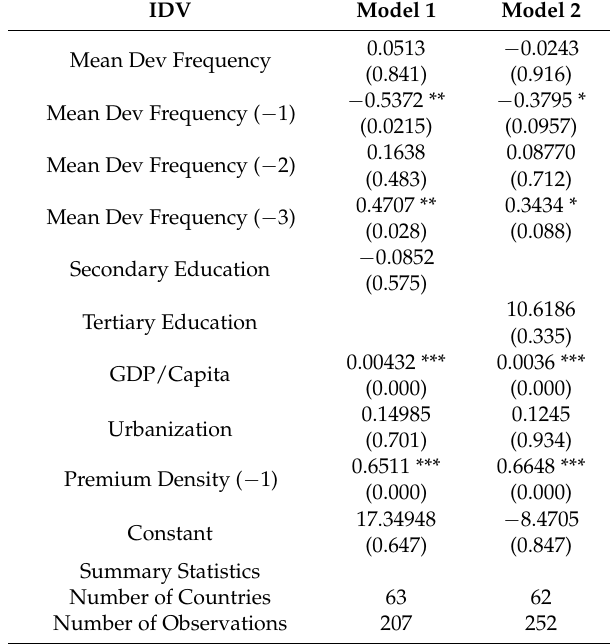
Table 1. Determinant of property and casualty insurance (PCI) with frequency of extreme events as memory cues: panel data results